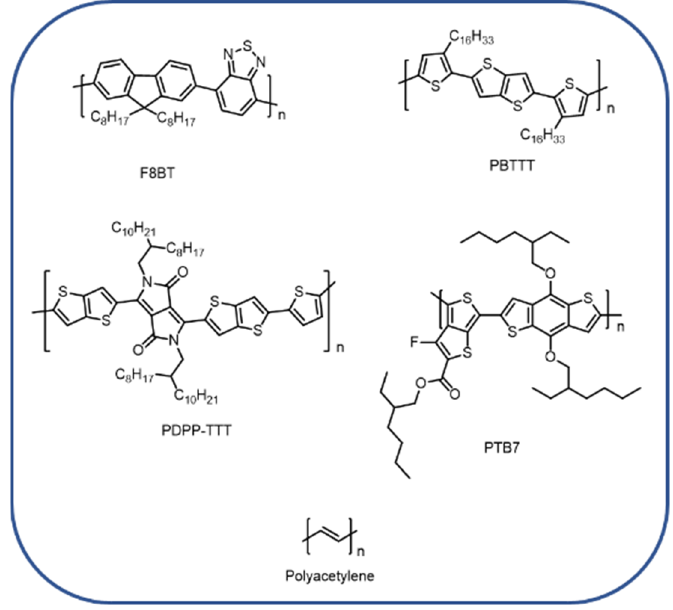
Figure 6. Chemical structures of polymeric semiconductors.